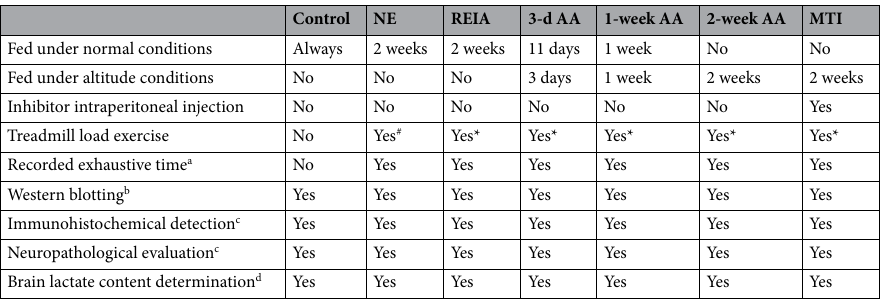
Table 2. The study protocol for each group. Sample size: a n = 9 per group; b n = 3 per group; c n = 3 per group; d n = 3 per group. Treadmill load exercise: *exercise under simulated high-altitude, low-pressure and hypoxic conditions; # exercise under normal pressure and normoxic